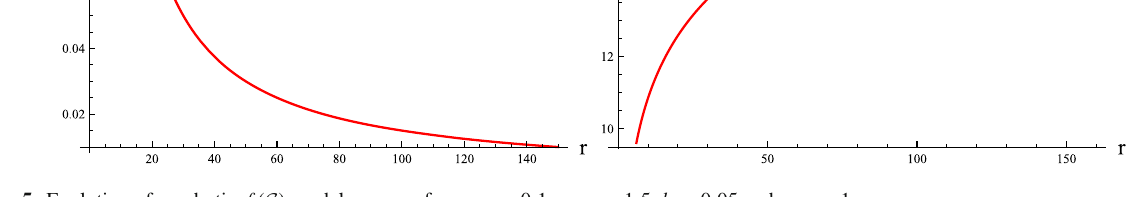
Fig. 5 Evolution of quadratic f ( G ) model versus r for χ 7 = − 0 . 1, ρ 0 = − 1 . 5, k = 0 . 05 and w = − 1